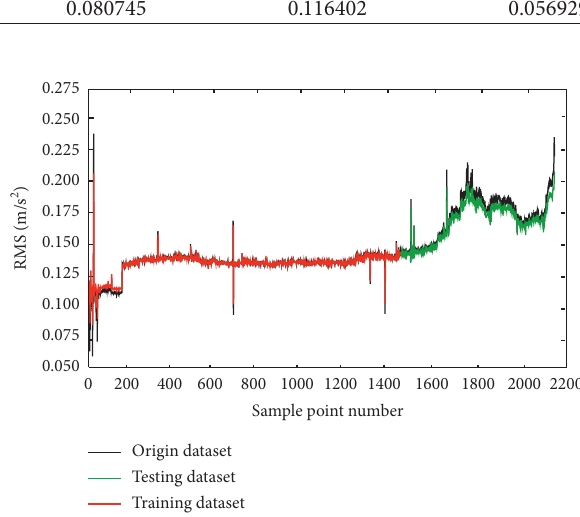
Figure 10: The prediction ability of the Attention-LSTM